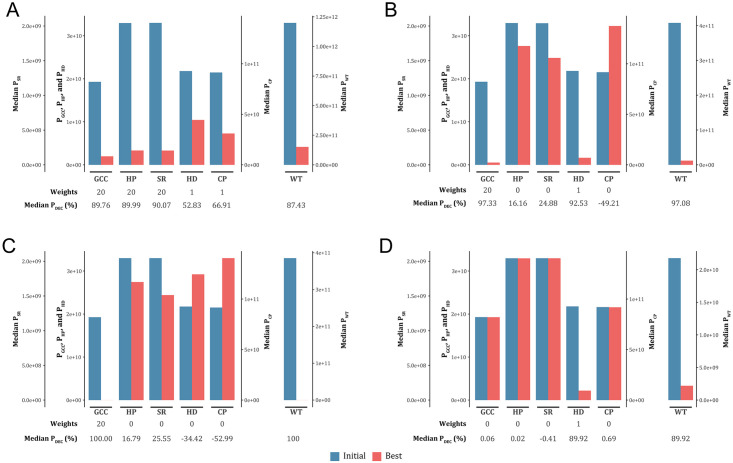
Results from test runs in four different conditions.All five barcode factors (A), two factors (GCC and HD; B), one factor (GCC; C) and another single factor (HD; D) were considered in the conditions for selecting an optimal barcode set in each condition. Steel blue and tomato red bars represent penalty scores of the barcode factors in initial and final sets, respectively. PGCC, PHP, PSR, PHP, and PCP represent penalty scores for GCC, HP, SR, HD, and CP, respectively. PDEC means a percent decrease in penalty scores obtained by comparing results between initial and best cycles.